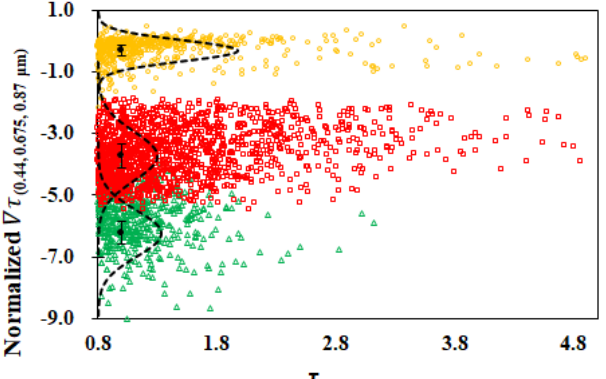
Figure 6. Based on the dataset used for Figure 5b, the result after screening of AOD (0.44 µ m) > 0.8 with confident single scattering albedo, and normalized by AOD (0.87 µ m) is shown. Furthermore, mappings (dashed curves) with normal distribution and mean values (black dots) are denoted.